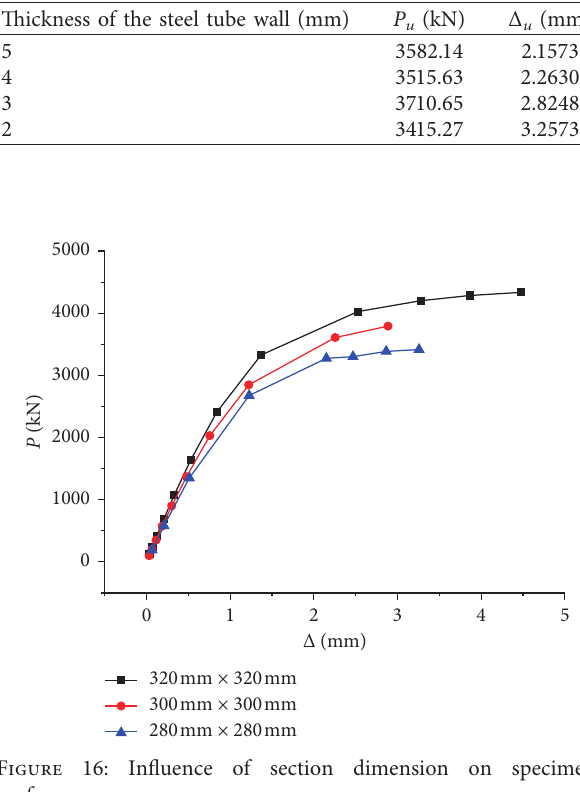
Figure 16: Influence of section dimension on specimen